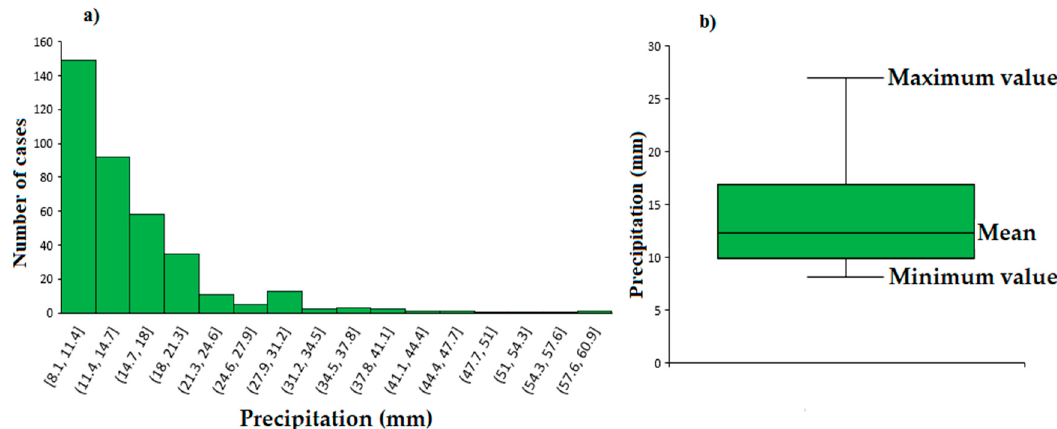
Figure 5. Histogram ( a ) and box diagram ( b ) of the network-averaged extreme rainfall observation series considered in the investigation. In the box diagram, the whiskers correspond to maximum and minimum values, excluding outliers. The box shows the standard deviation and the line is the mean value.